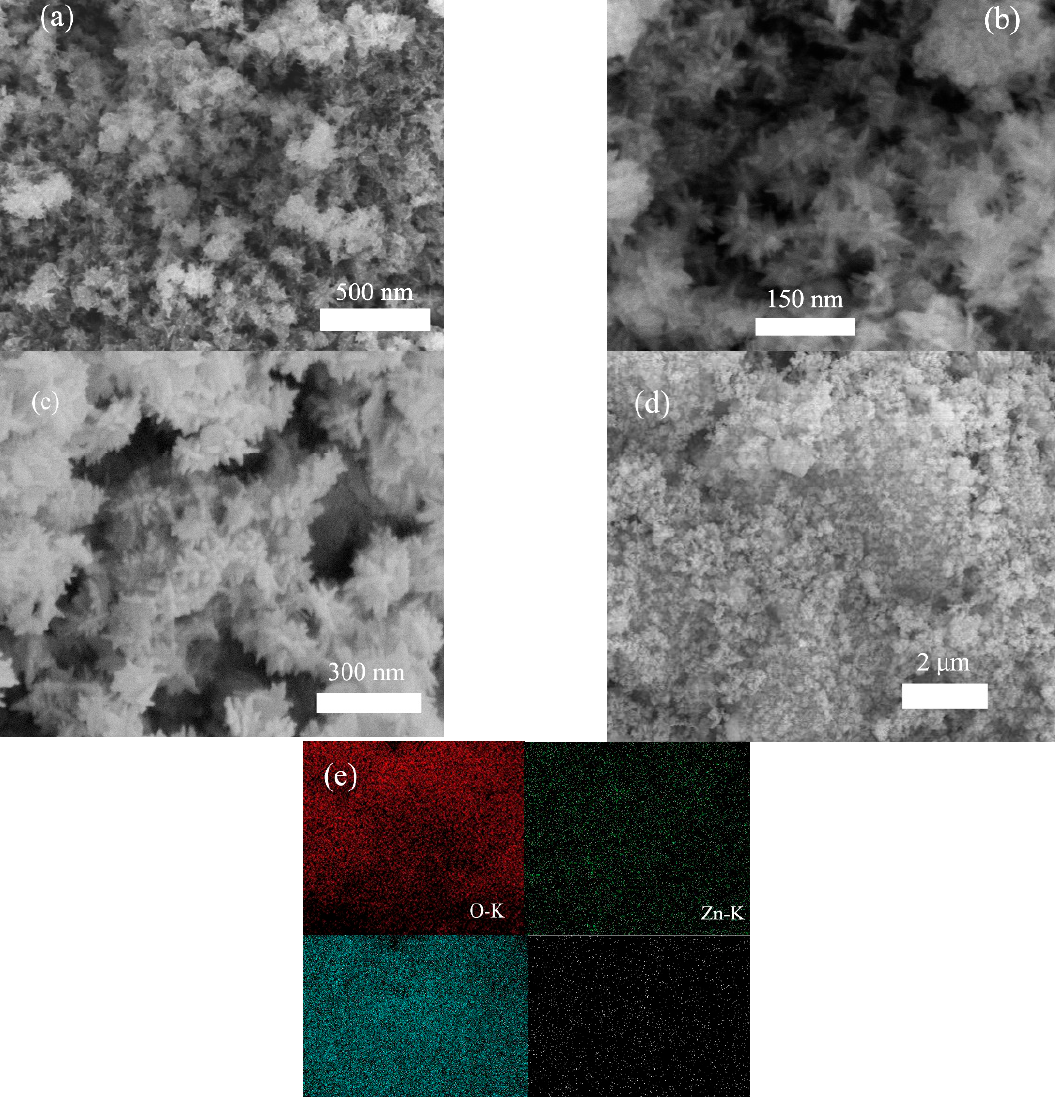
Figure 1. ( a ) and ( b ) Low-magnification and high-magnification FESEM images of P-ZSO/SnO 2 , ( c ) Figure 1. ( a , b ) Low-magnification and high-magnification FESEM images of P-ZSO / SnO 2 , ( c ) FESEM FESEM image of the ZSC1.5 sample, ( d ) and ( e ) SEM image and its corresponding EDS mapping of image of the ZSC1.5 sample, ( d , e ) SEM image and its corresponding EDS mapping of the ZSC1.5 the ZSC1.5 sample.